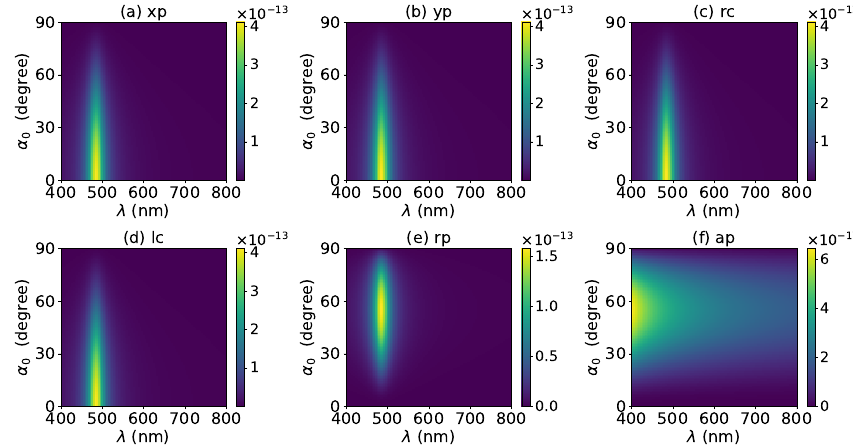
Figure 3. The same as in Figure 2, but with N = 1.